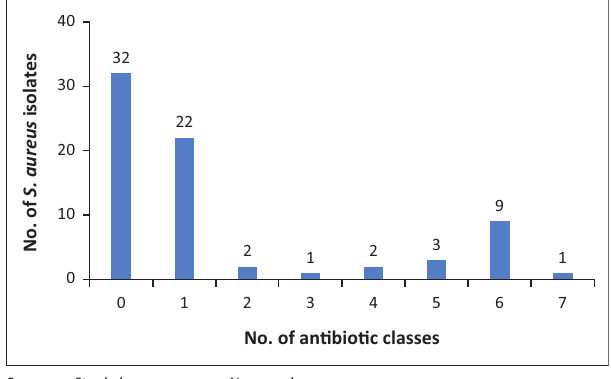
FIGURE 1: Distribution of antibiotic-resistant Staphylococcus aureus isolates ( n = 72) from poultry meat samples in South Africa, 2015–2016.